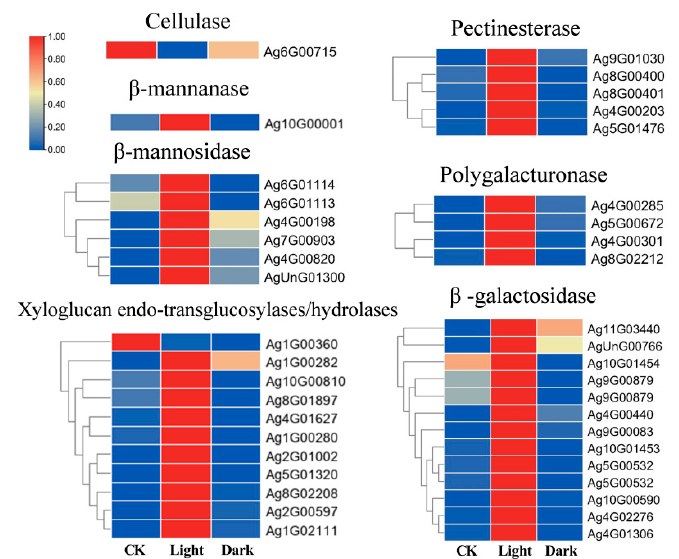
Figure 6. Heatmap visualization of the expression changes of the DEGs related to cell wall remodeling enzymes (CWREs). The transcripts of DEGs were normalized as 0–1. Gene IDs are showed by the legend on the right. Expression levels ranging from red to blue indicate high to low expression for genes, respectively.